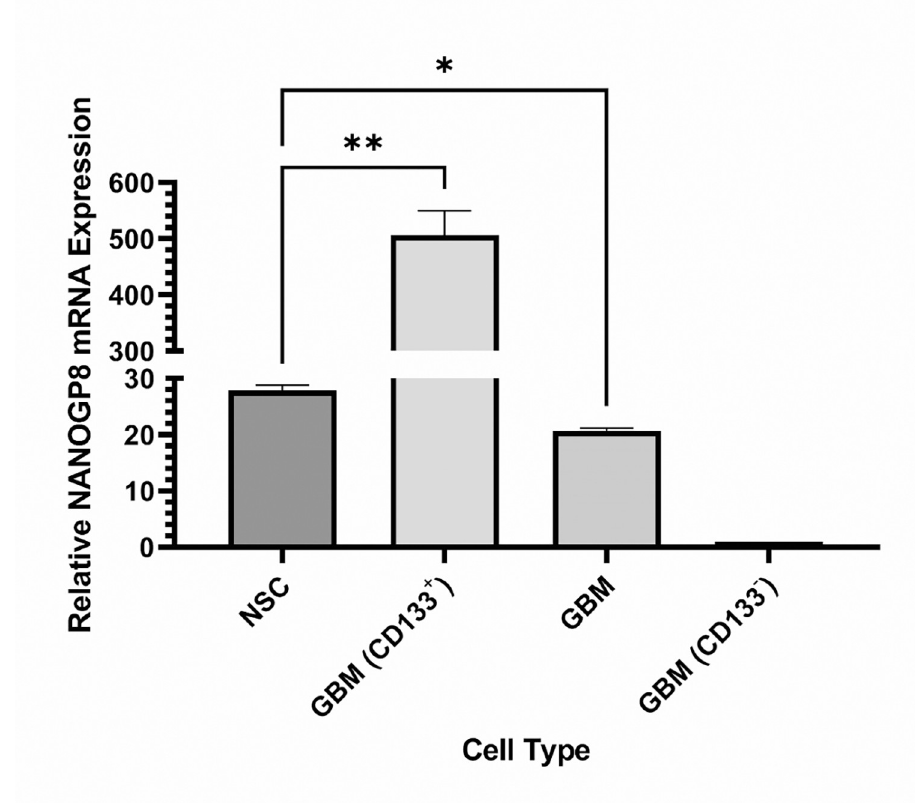
Fig 3. Quantitative PCR amplification of NANOGP8 transcript. CD133 + GBM cancer stem cells have significantly higher expression as compared to the GBM primary cells comprising a mix of undifferentiated CD133 + CSCs and differentiated CD133 - cancer cells. CD133 - cells express negligible NANOGP8